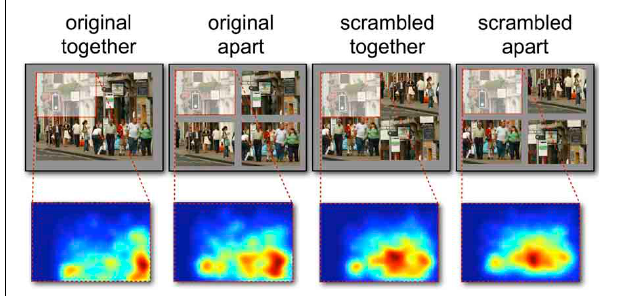
FIGURE 7 | Fixation distributions in the top left quadrant of scenes, with the area examined show in the top